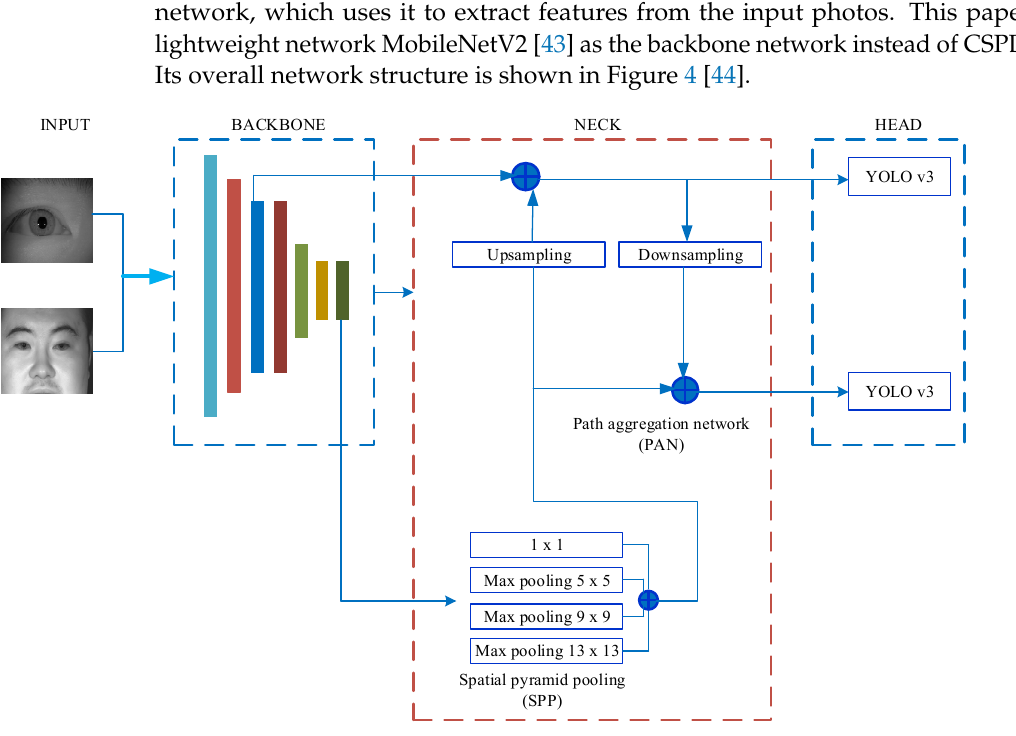
Figure 3. Sample image of the dataset used to train YOLO V4. ( a ) Example image of CASIA-Iris-Thousand; ( b , d ) Manual label of the outer boundary of the iris; ( c ) Example image of CASIA-Iris-distance [22].